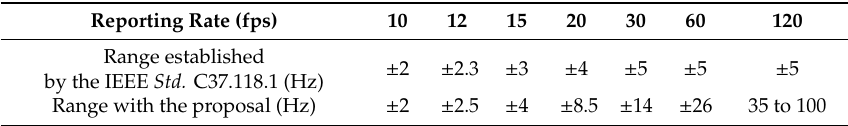
Figure 6. Magnitude and TVE results for linear frequency ramp: ( a ) 10 fps, ( b ) 12 fps, ( c ) 15 fps, ( d ) 20 fps, ( e ) 30 fps, ( f ) 60 fps and ( g ) 120 fps. Table 4. Frequency deviation ranges for the dynamic